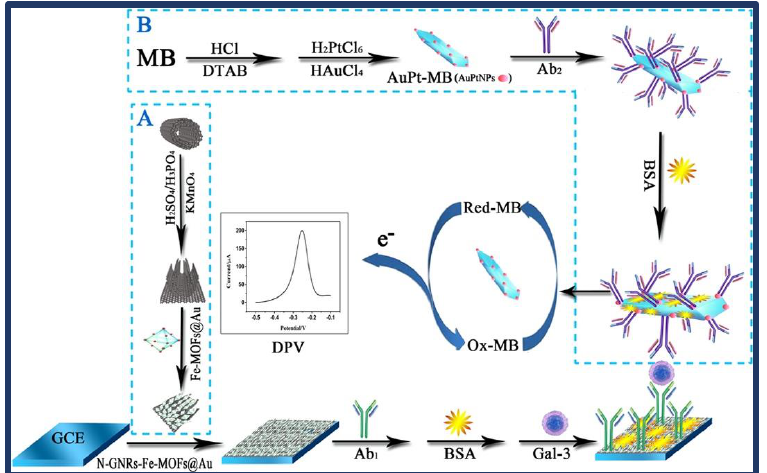
Figure 3. Schematic representation of the electrochemical immunosensor interfaces’ step-by-step assembly process. The methods used to prepare the bioconjugates AuPt-MB-Ab2 and N-GNRs-Fe- MOFs@AuNPs in ( A ) and ( B ), respectively. The differential pulse voltammetry (DPV) scan was performed from − 0.5 V to − 0.1 V with a pulse amplitude of 50 mV, pulse width of 50 ms, and pulse period of 100 ms. Reprinted from Ref. [44] with permission from Elsevier.